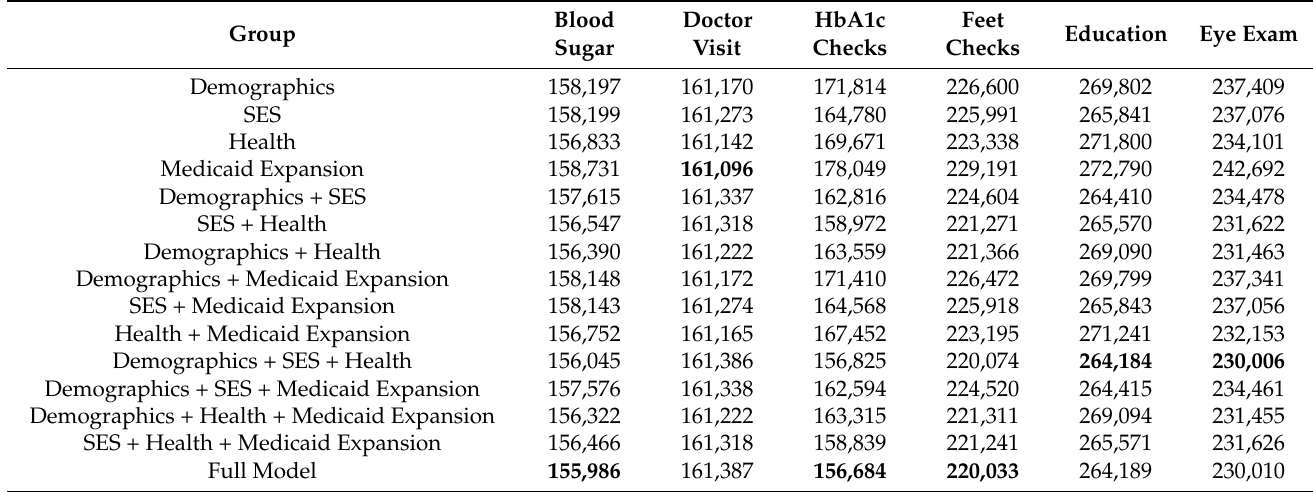
Table 4. Akaike information criterion for sub-models.